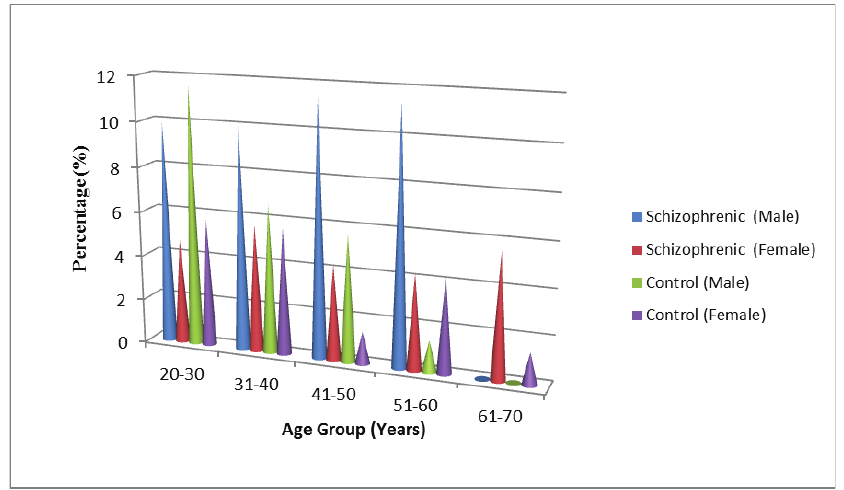
Figure 1: Age and Sex distribution of the recruited population in percentage